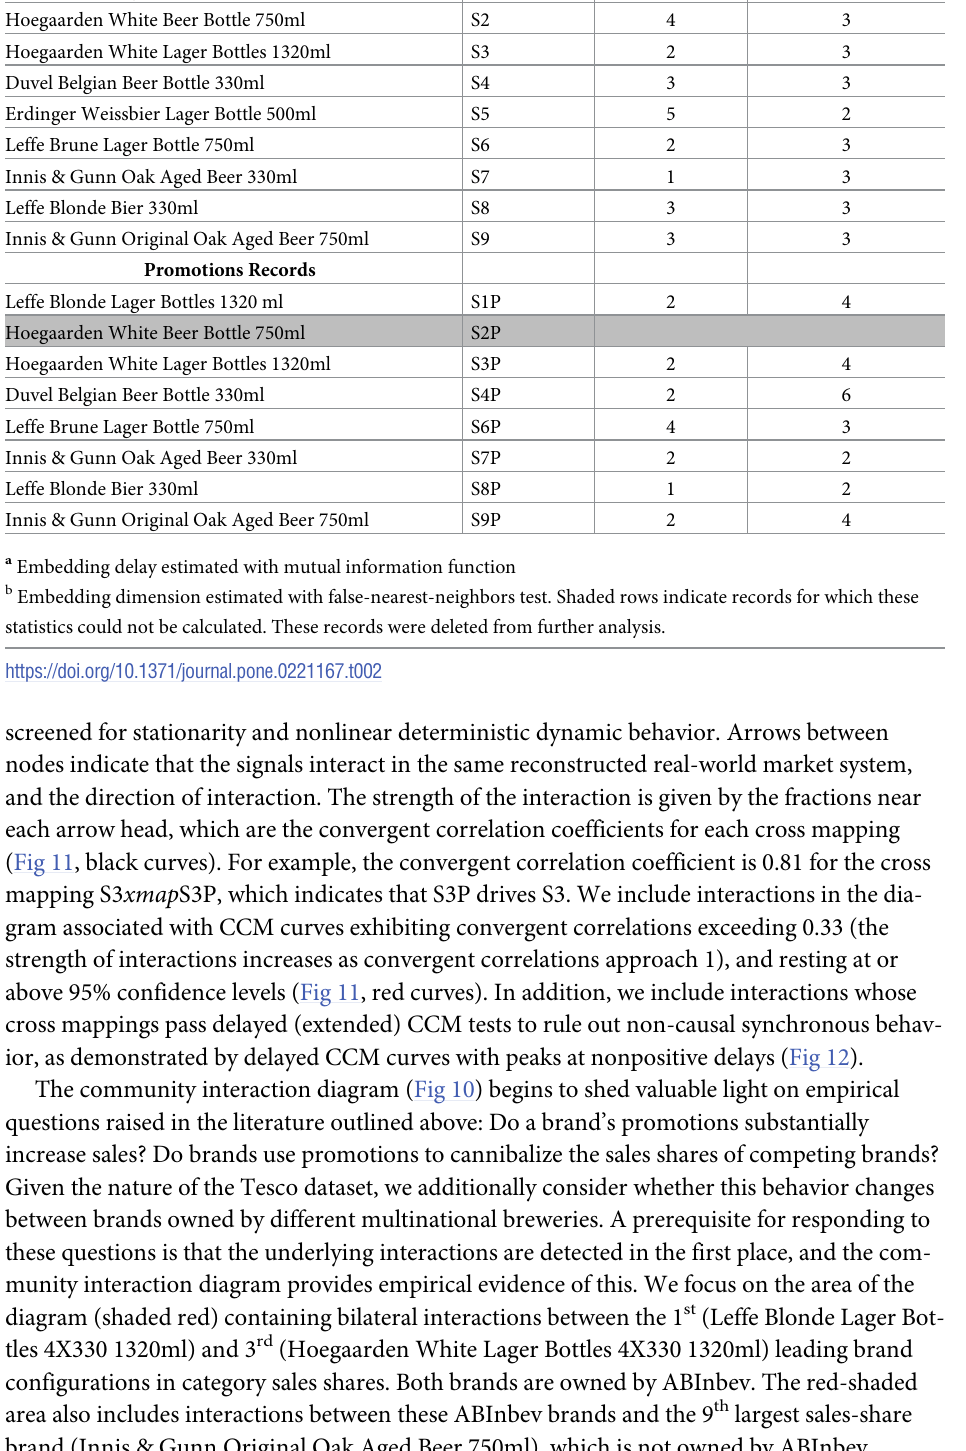
Table 2. Embedding parameters.